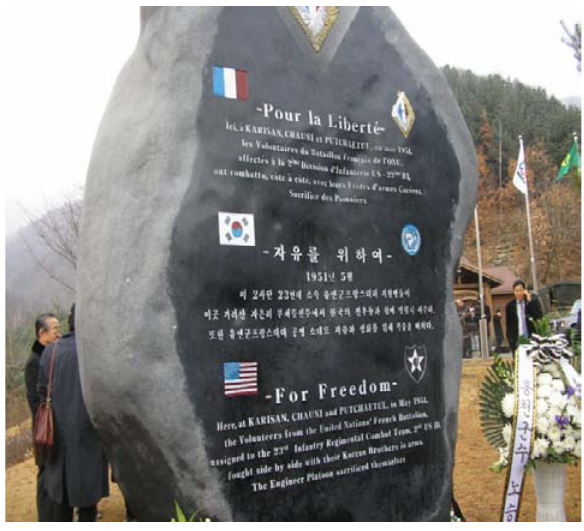
Figure 4. The Puchaetŭl